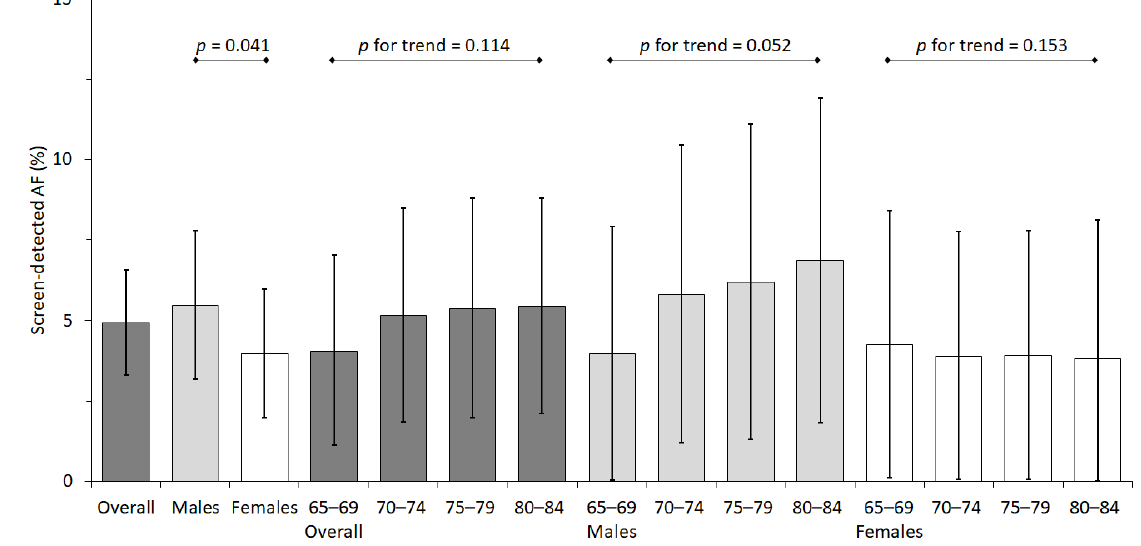
Figure 3. Prevalence estimates of screen-detected atrial fibrillation as percentages with 95% confidence intervals in the prospective cohort study. AF: atrial fibrillation.